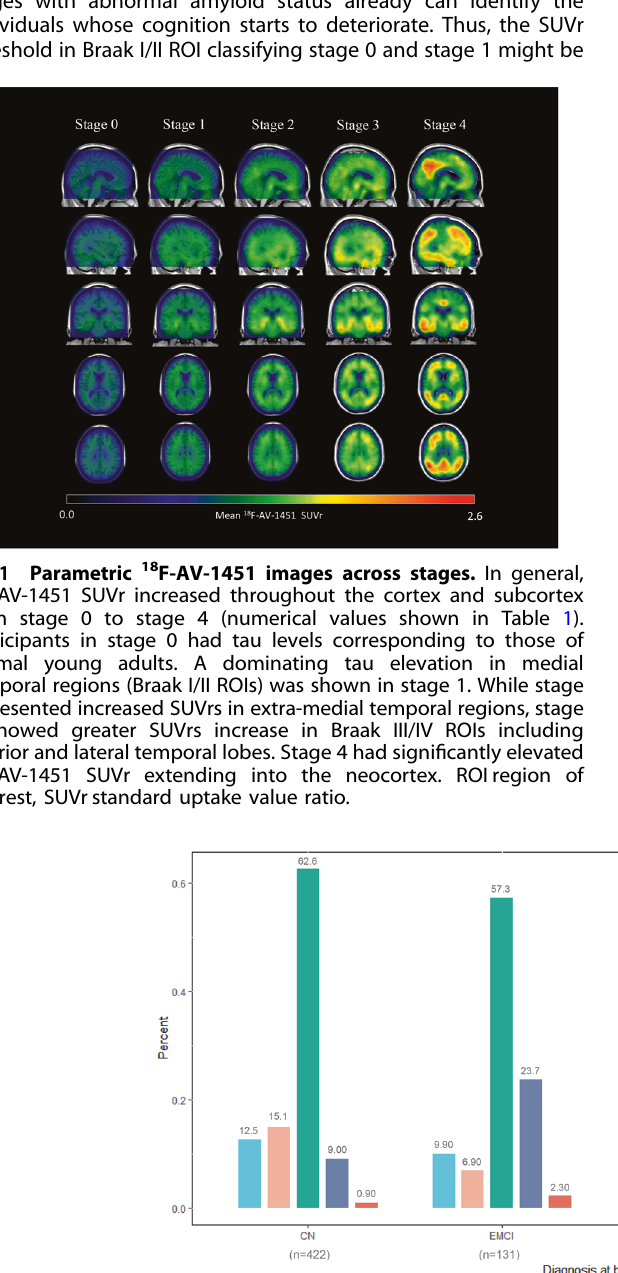
Fig. 2 Distribution of different tau stages across clinical diagnostic groups. Under the horizontal axis are numbers of included participants in four diagnostic groups. Proportions of low stages and intermediate stages (stage 0, 1, 2) decreased with clinical deterioration, while proportions of high stages (stage 3, 4) increased. CN cognitively normal, EMCI early mild cognitive impairment, LMCI late mild cognitive impairment.